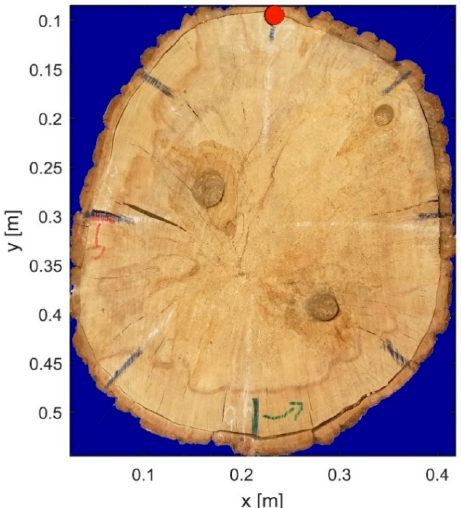
Figure 5. The oak tree trunk investigated at The Faringdon Centre-Non-Destructive Testing Centre, University of West London (UWL), UK. Measurements were taken counter-clockwise and the red circle denotes the starting point.